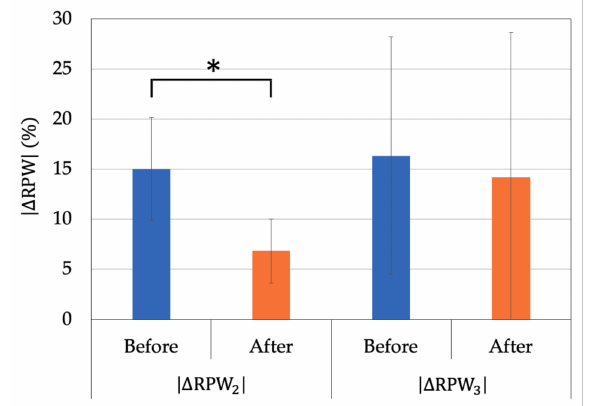
Figure 7. Results of | ∆ RPW 2 | and | ∆ RPW 3 | before and after applying local vibratory stimulation to the muscle spindles (higher frequency) and Vater-Pacini corpuscle, respectively. | ∆ RPW 2 | = absolute difference between the measured value of RPW 2 for elderly patients with NSLBP and the mean value of RPW 2 for healthy adults; | ∆ RPW 3 | = absolute difference between the measured value of RPW 3 for elderly patients with NSLBP and the mean value of RPW 3 for healthy adults; ∗ = statistically significant at p < 0.05.